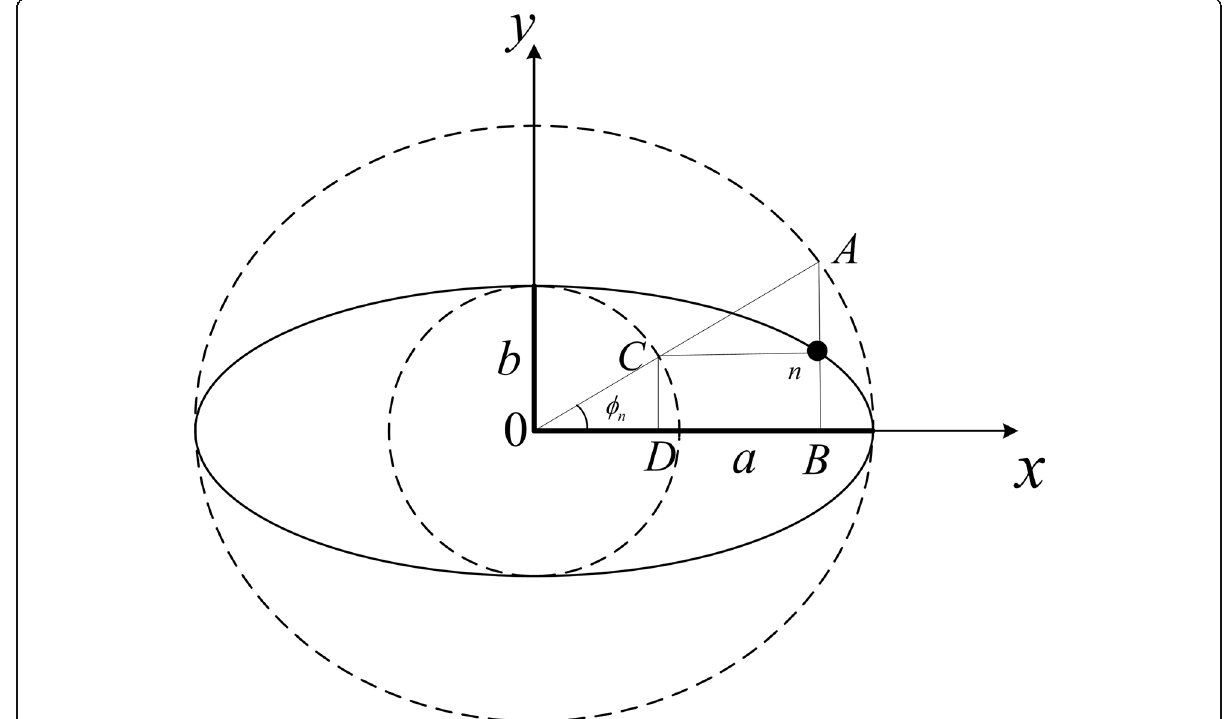
Fig. 1 Structure of elliptical antenna